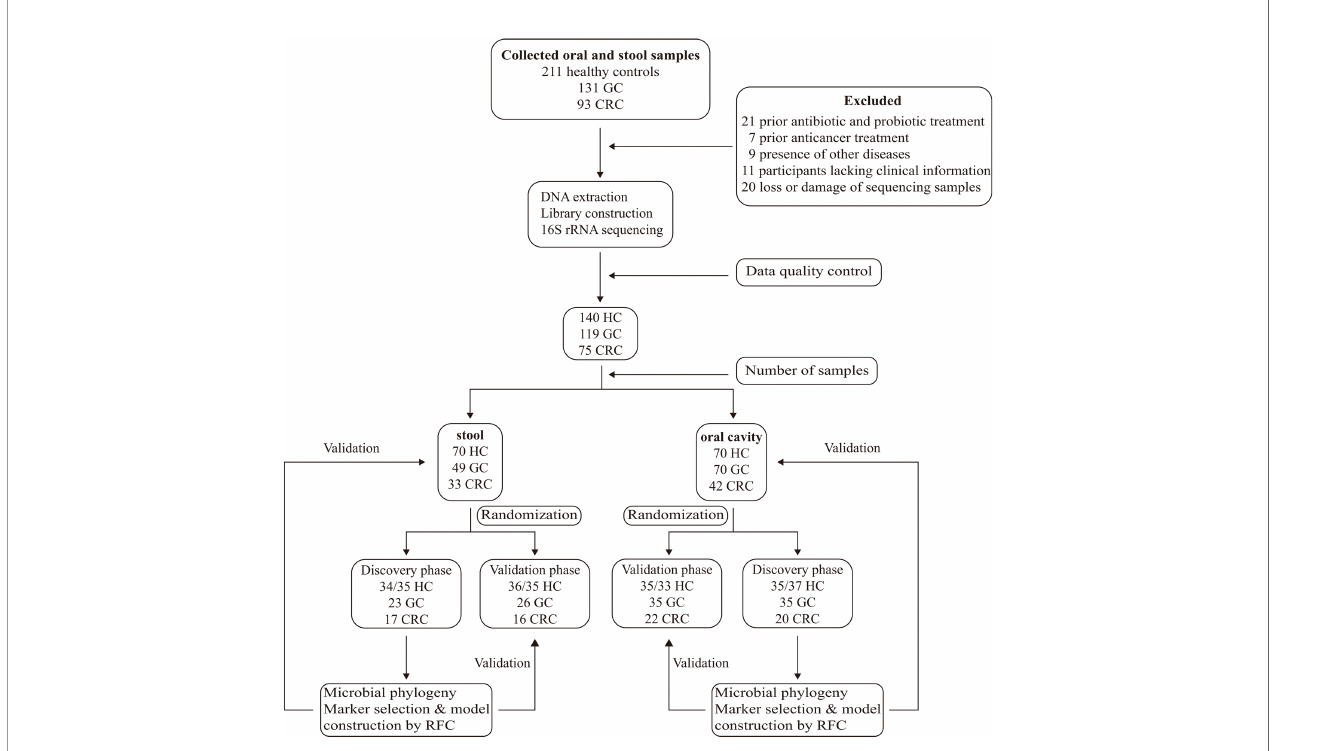
FIGURE 1 | Study design and fl ow diagram. A total of 435 oral and fecal samples from the same area were prospectively collected and 334 samples (140 HC, 119 GC, and 75 CRC) were included after systematic elimination and pathological diagnosis. The above samples came from 199 quali fi ed participants (including 70 healthy controls, 76 GC patients, and 53 CRC patients) and were randomly divided into a discovery phase and a veri fi cation phase. In the discovery phase, we characterized microbiota of 72 HC (37/35 oral, 35/37 stool), 60 GC (35 oral, 25 stool), and 38 CRC (21 oral, 17 stool), and identi fi ed microbial markers. The GC and CRC classi fi ers were constructed through the random forest model among GC, CRC cohort, and HC cohort. In the validation phase, we used 68 HC (33/35 oral, 35/33 stool), 59 GC (35 oral, 24 stool), and 37 CRC (21 oral, 16 stool) to validate diagnosis ef fi cacy of the GC and CRC classi fi ers. Furthermore, all oral samples (70 HC, 70 GC, and 42 CRC) and fecal samples (70 HC, 49 GC, and 33 CRC) were used as another independent diagnostic stage to verify the potential of the GC and CRC classi fi ers. HC, healthy controls; GC, gastric cancer; CRC, colorectal